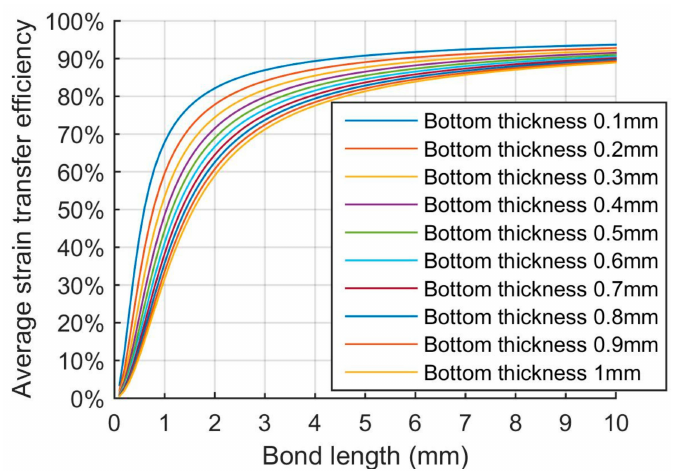
Figure 4. Influence of half-bond length and adhesive-bottom thickness on average strain-transfer rate (ASTR) calculated from three-layer model.